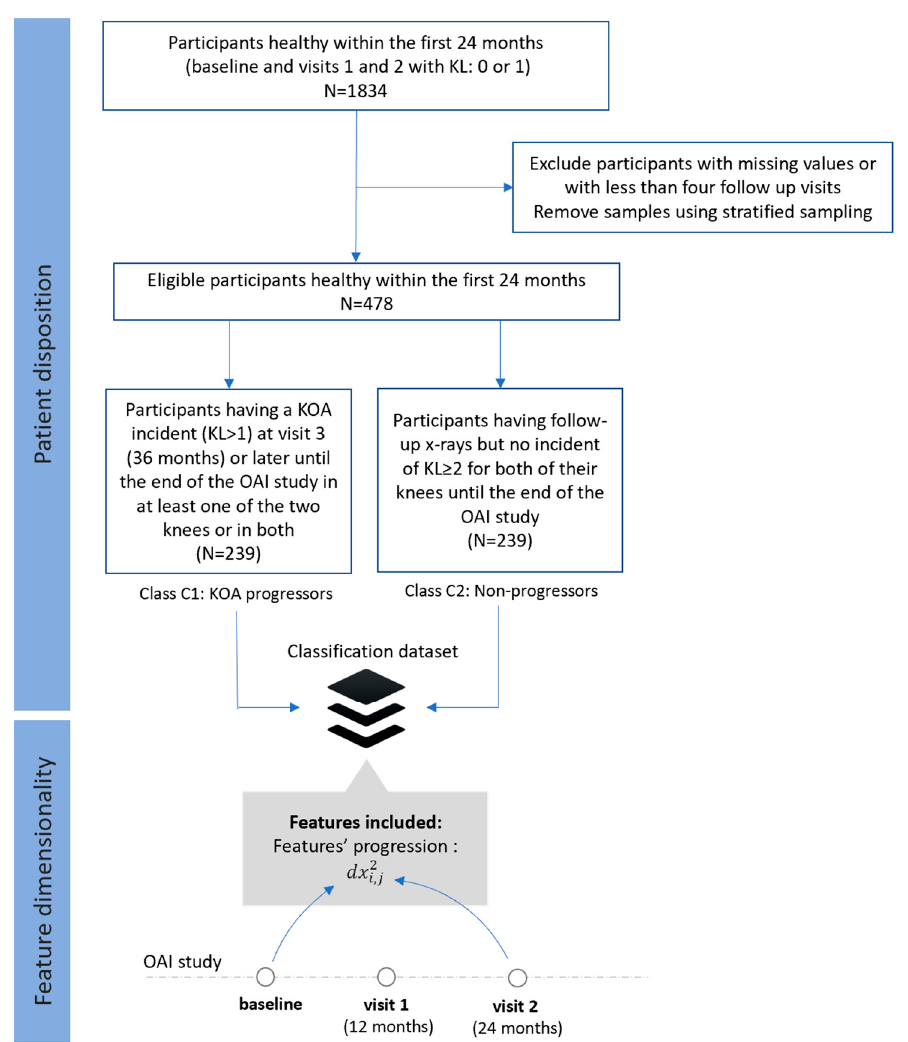
Figure 3. Flow chart of study design for dataset C.